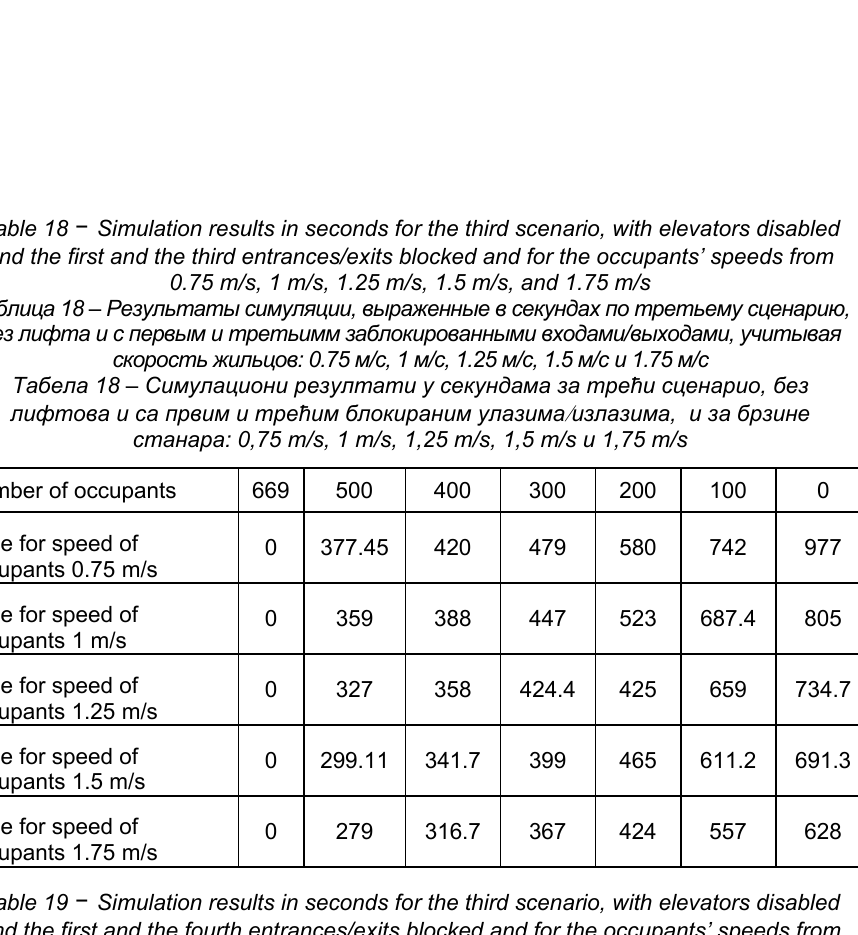
178 Table 18 – Simulation results in seconds for the third scenario, with elevators disabled